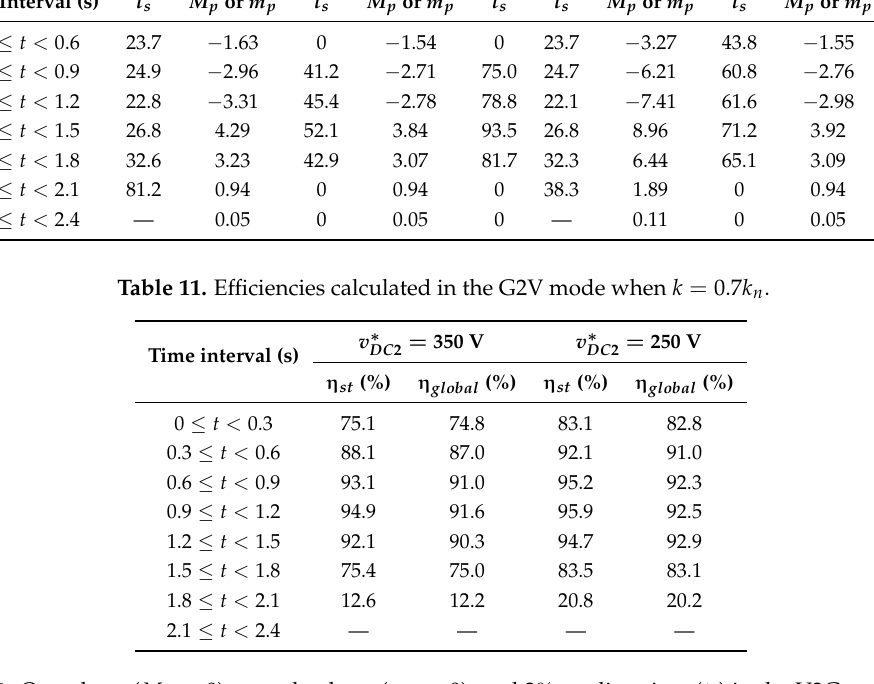
Table 12. Overshoot ( M p > 0) or undershoot ( m p < 0), and 2%-settling time ( t s ) in the V2G mode for i b , v DC 2 , and v DC 1 considering k = 0.7 k n .